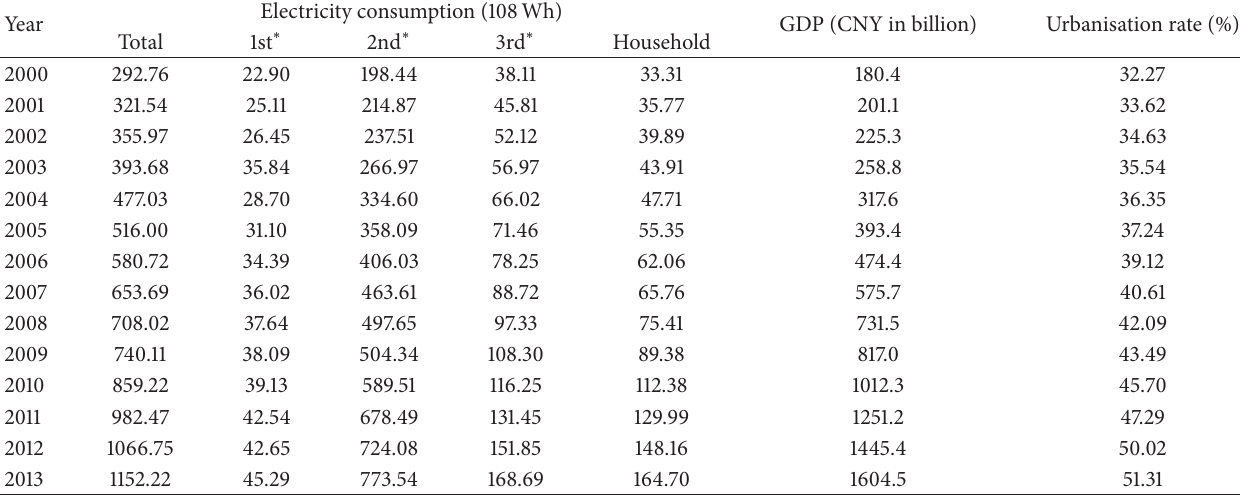
Table 1: Historical data of electricity consumption, GDP, and urbanisation rate in Shaanxi province from 2000 to 2013. Year